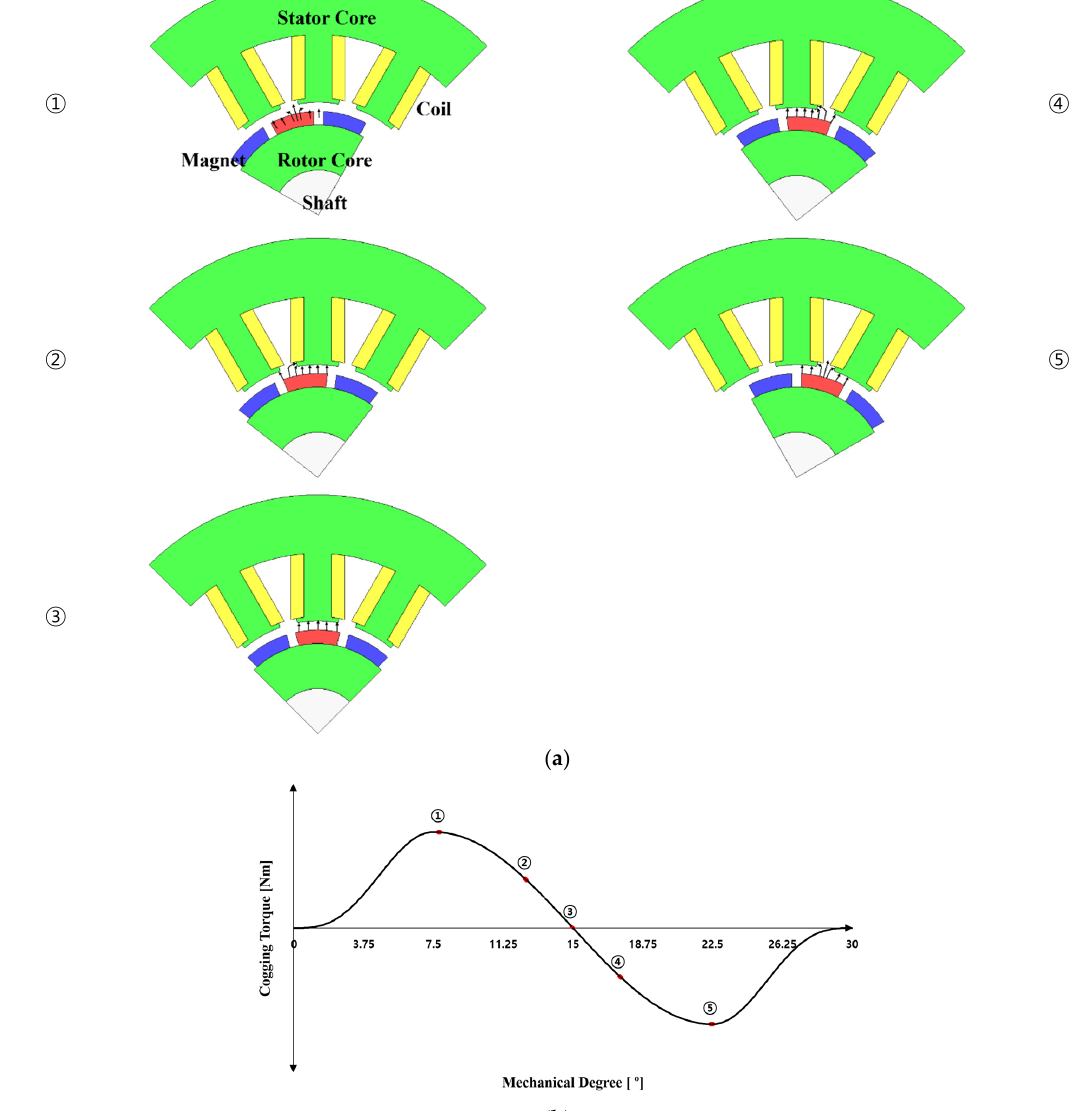
Figure 1. Cogging torque generation mechanism ( a ) distribution of magnetomotive force due to permanent magnet rotation of motor ( ① – ⑤ timeline) ( b ) cogging torque due to permanent magnet rotation of motor. Three-phase motors can be initially start-up by generating a rotating magnetic field.